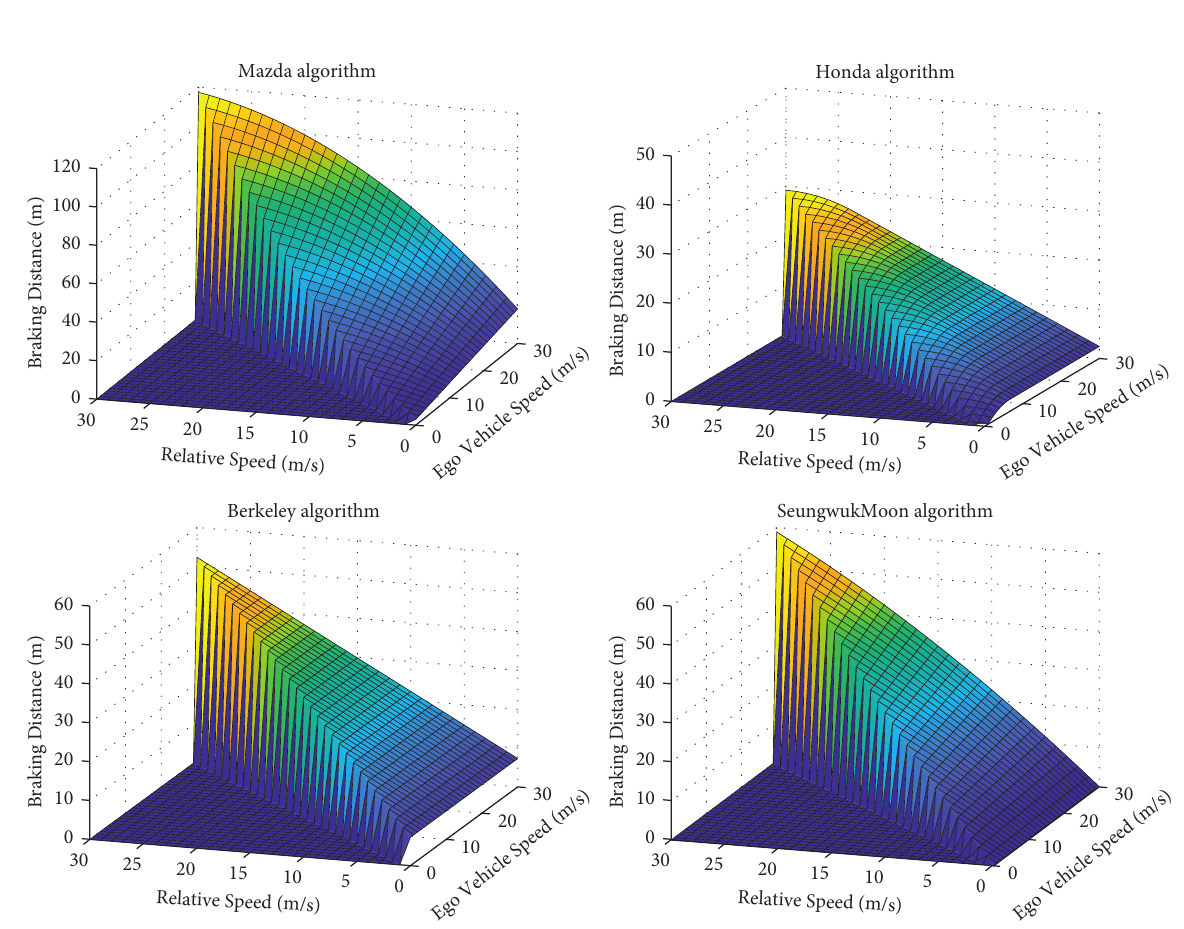
Figure 3: Simulation results of the four algorithms.